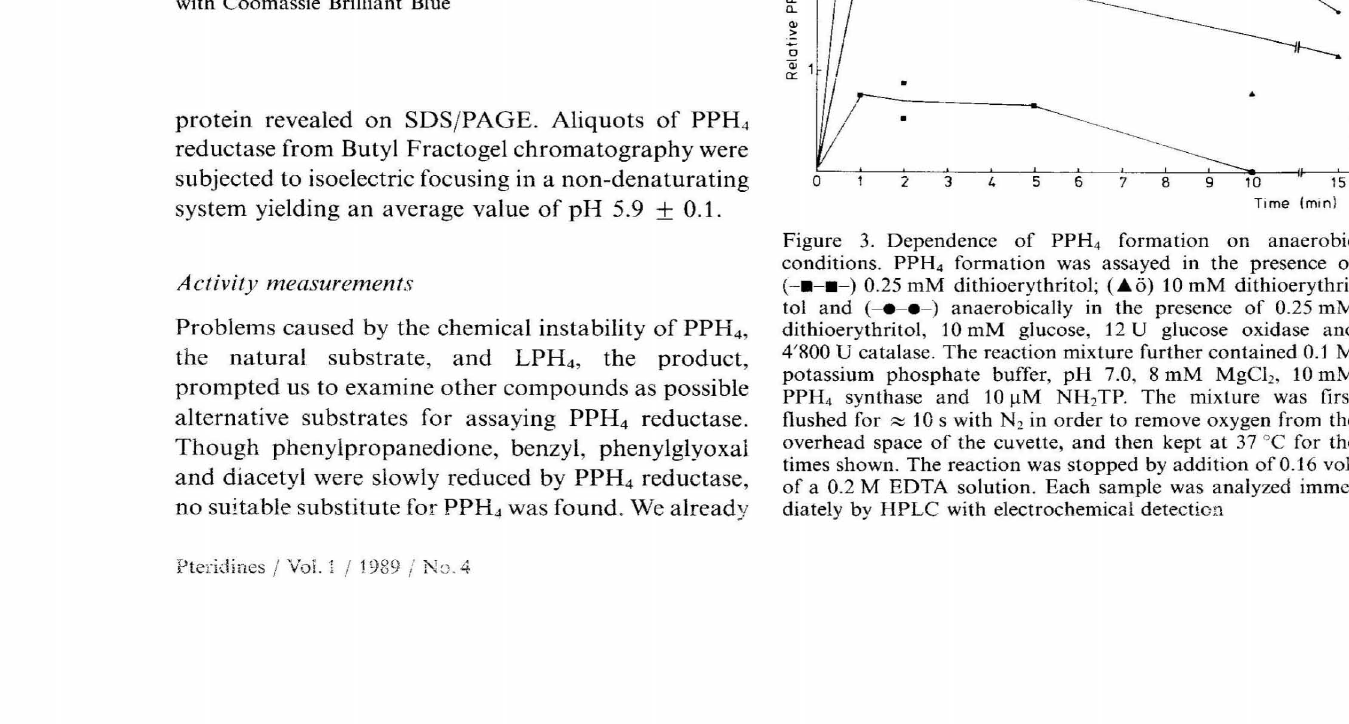
Figure 2. SDSjPAGE (12.5% polyacrylamide) of PPH 4 reduc tase at different purification steps, and from two distinct prep arations: (A) Butyl Fractogel step (~ 61 Ilg); (B) blue Sepharose (first chromatography) (~ 1 Ilg); (C) Blue Sepharose (rechro matography) (~2Ilg); (D) Molecular mass standards; (E) Mono Q FPLC (~ 141lg) after chromatography on (F) Blue Sepharose (first chromatography) (~ 5 Ilg). Visualization was with Coomassie Brilliant Blue